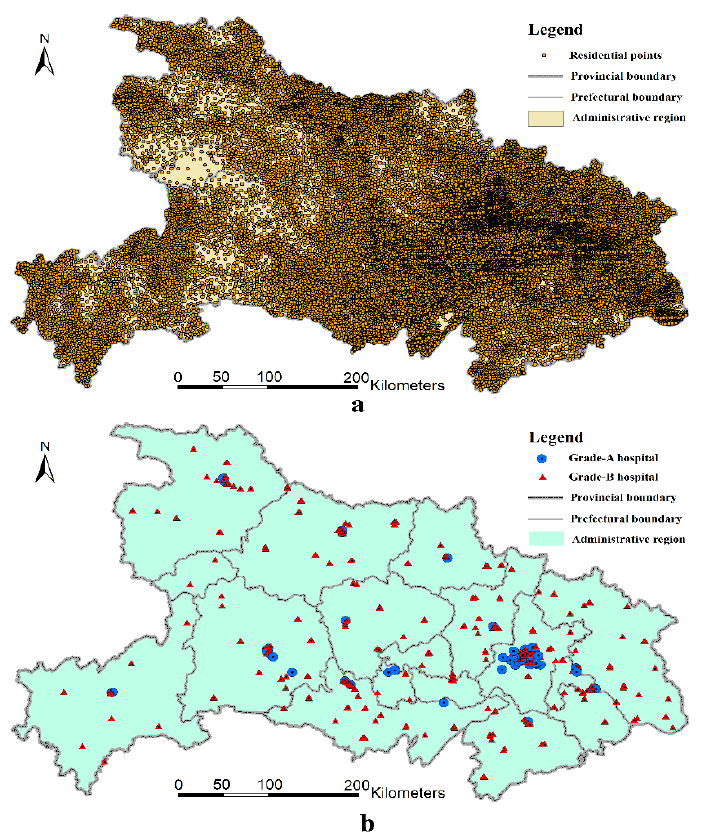
Figure 2. The geographical distribution of residential points ( a ), and the geographical distribution of Grade-A and Grade-B hospitals in Hubei Province ( b ).